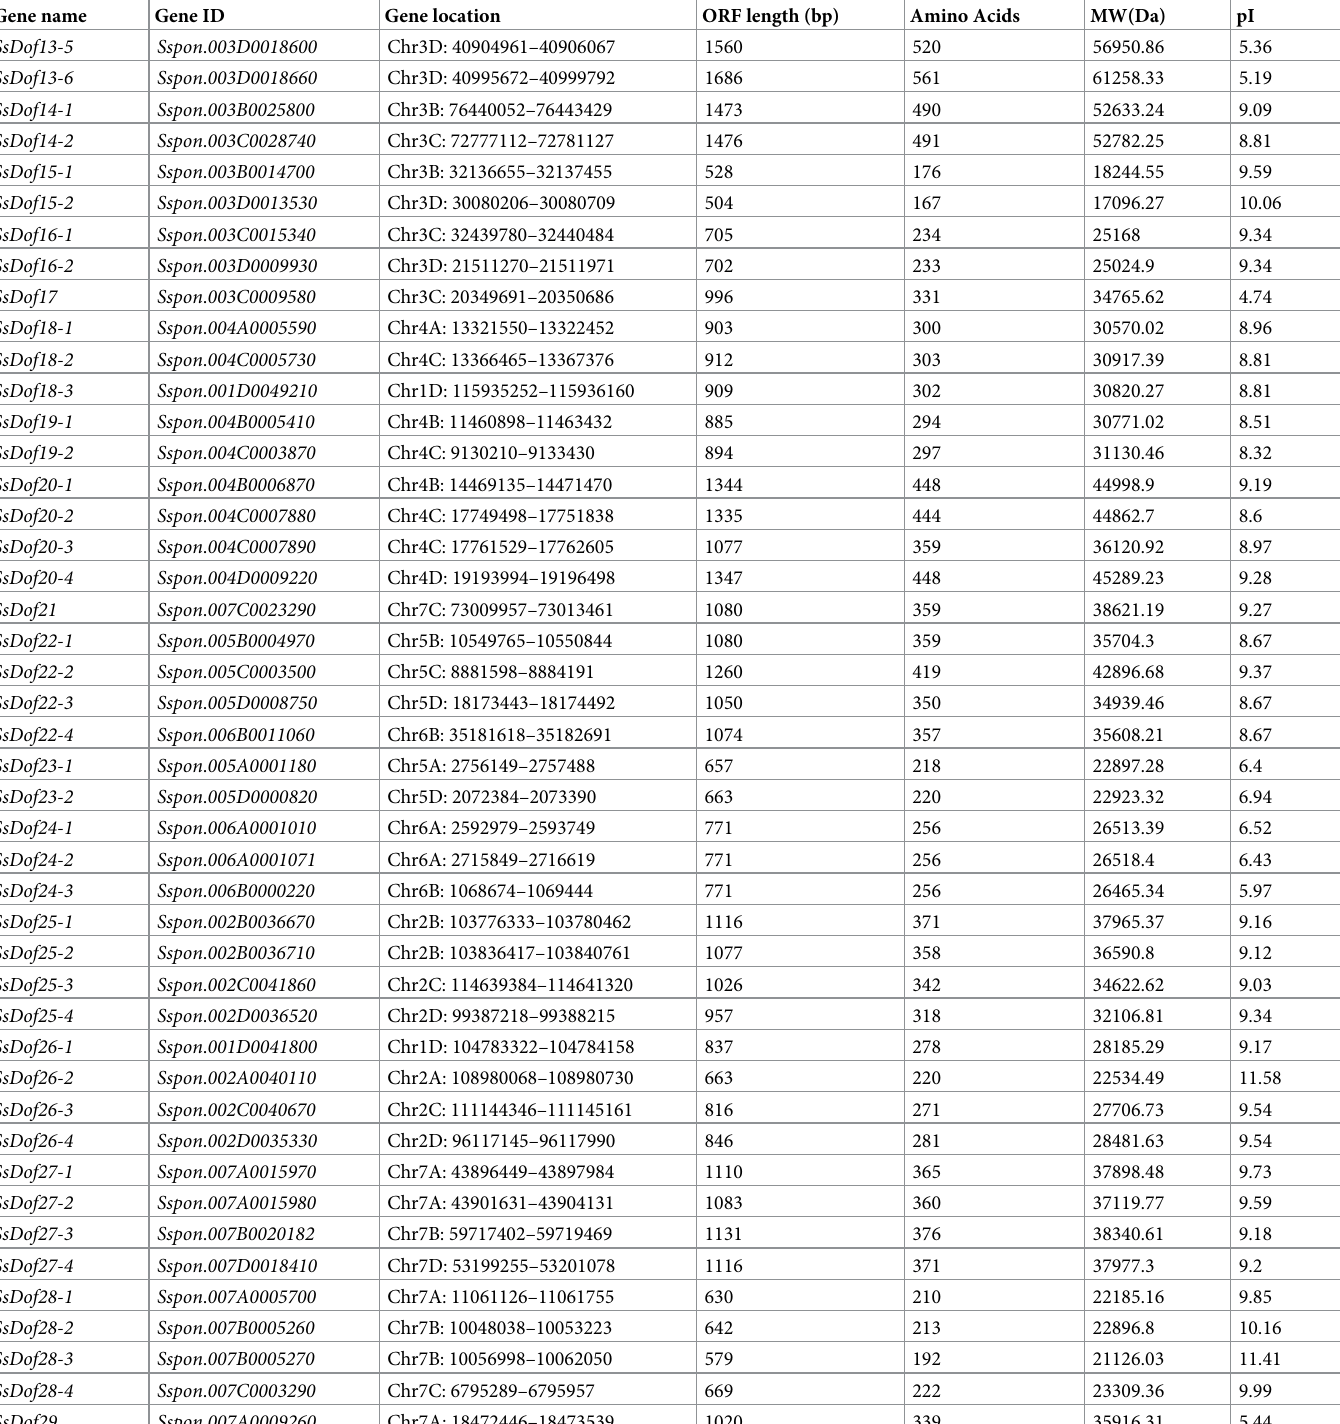
Table 3. Characterization of Dof genes in Saccharum spontaneum